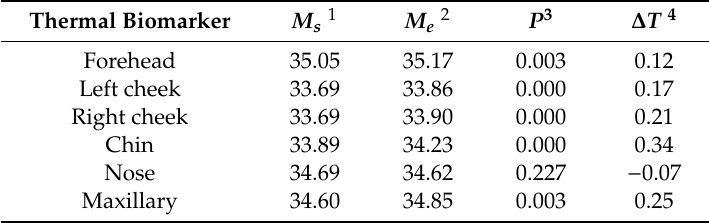
Table 3. t -test: paired two sample for means